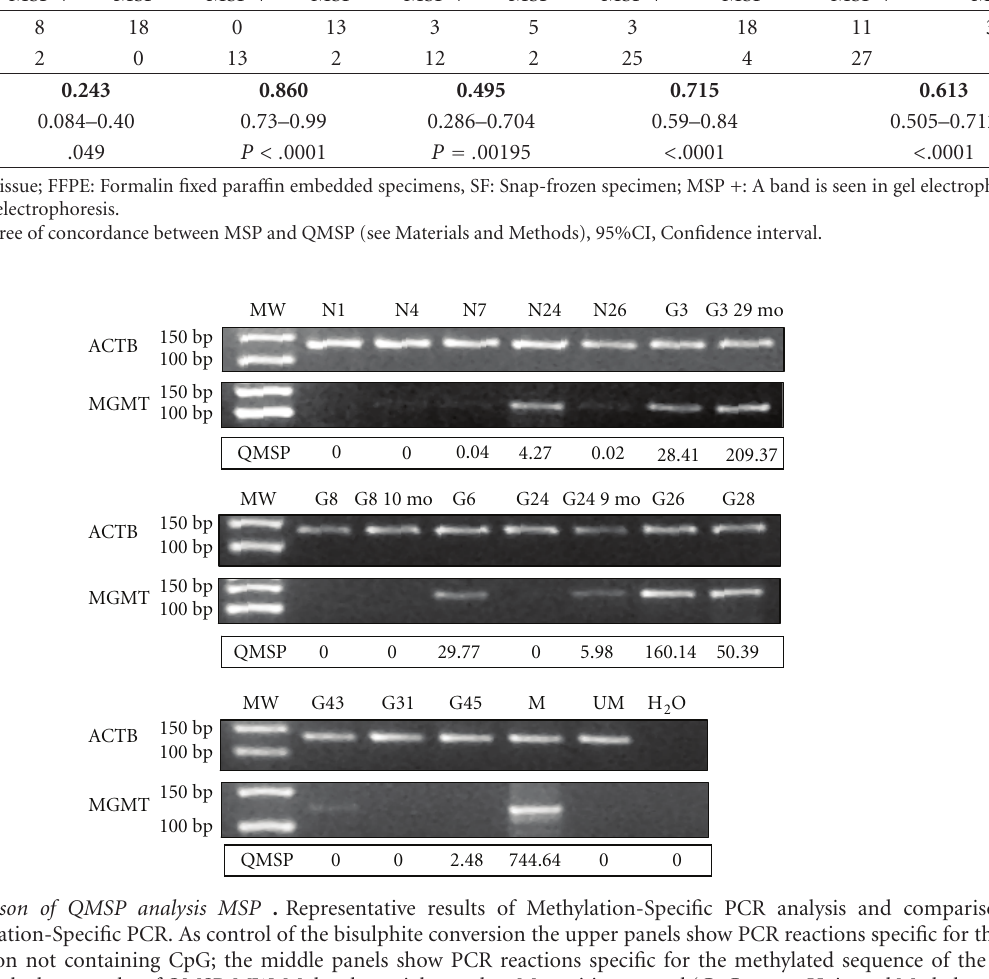
FFPE: Formal-fixed para ffi